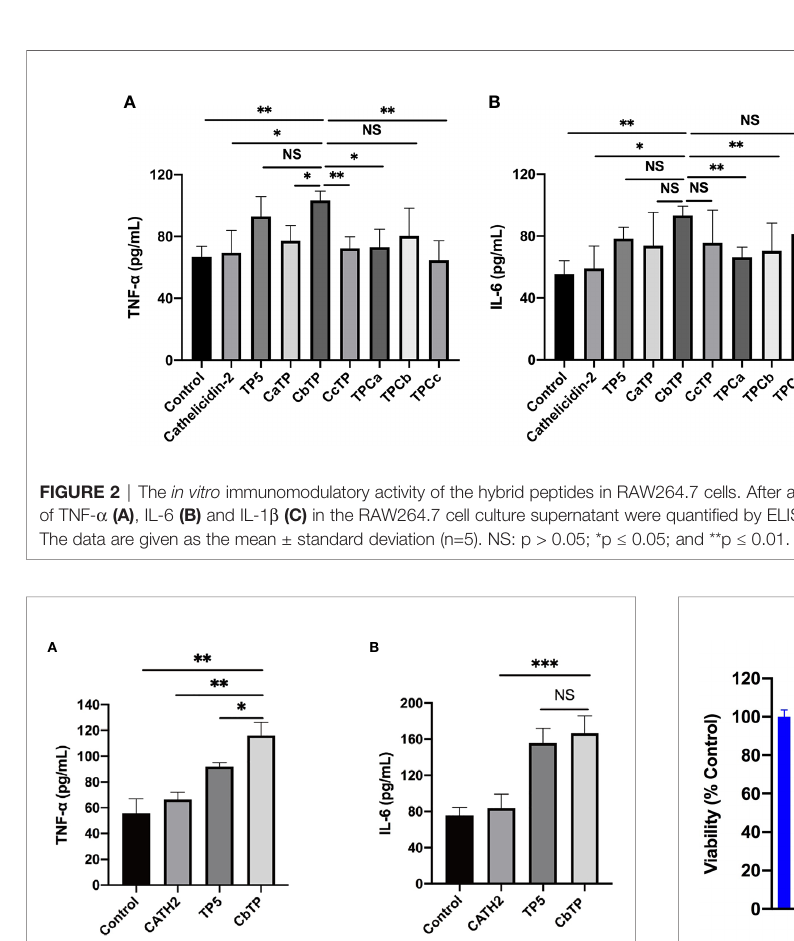
FIGURE 3 | The in vitro immunomodulatory activity of CATH2, TP5, and CbTP in human THP-1 monocyte-macrophage cells. After administration of 10 m g/mL peptides for 12 h, the protein levels of TNF- a (A) and IL-6 (B) in the THP-1 cell culture supernatant were quanti fi ed by ELISA. Statistical comparisons were performed by Student ’ s t test. The data are given as the mean ± standard deviation (n=5). NS: p > 0.05, *p ≤ 0.05, **p ≤ 0.01, and ***p ≤ 0.001.